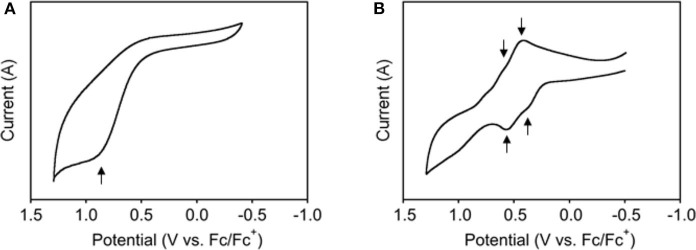
Cyclic voltammograms (V vs. Fc/Fc+) of (A) BPI-2 and (B) BPI-2/Pd polymer in CH2Cl2. Scan rate, 100 mV/s; working electrode, Pt; supporting electrolyte, 0.1 M Bu4NClO4.